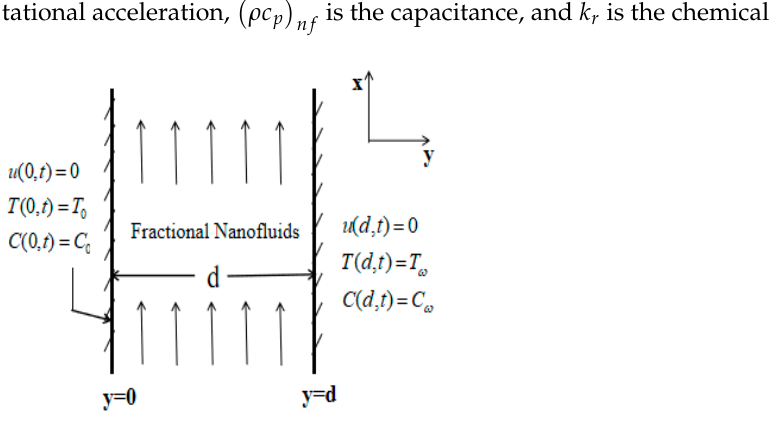
Figure 1. Geometric sketch.